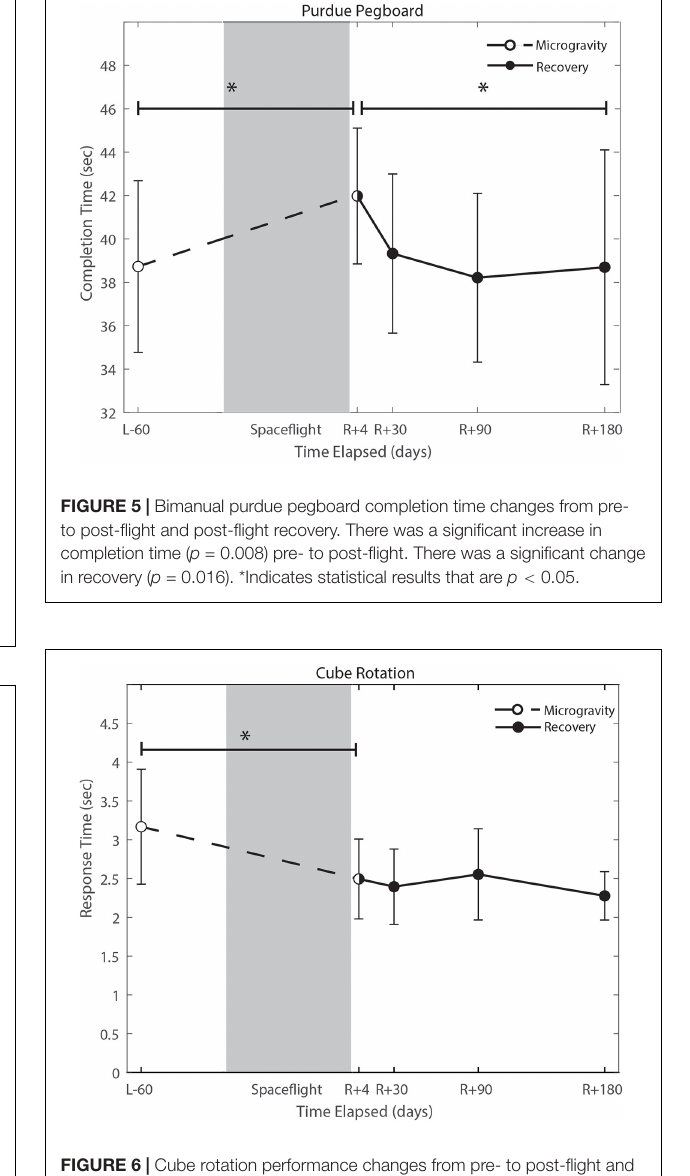
FIGURE 4 | Balance (SOT-5M) changes from pre- to post-flight and post-flight recovery. Sensory Organization Task 5 with head movements (SOT-5M) performance changes indicate that the microgravity environment resulted in a significant decrease in Equilibrium Score ( p = 0.001). There was a significant recovery of performance following spaceflight ( p = 0.005). *Indicates statistical results that are p < 0.05.